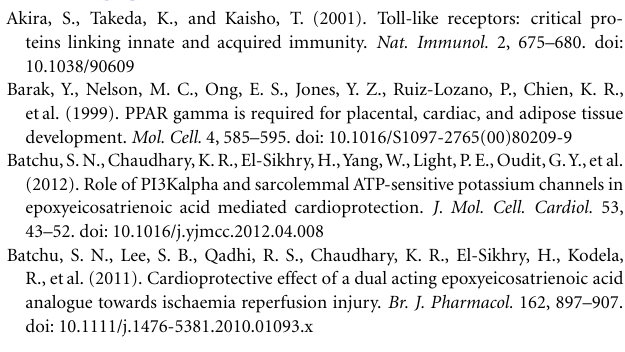
state. Increased EETs can act as PPAR γ agonists and inhibit NF- κ B-dependent signaling, shifting the cellular response to an anti-inflammatory